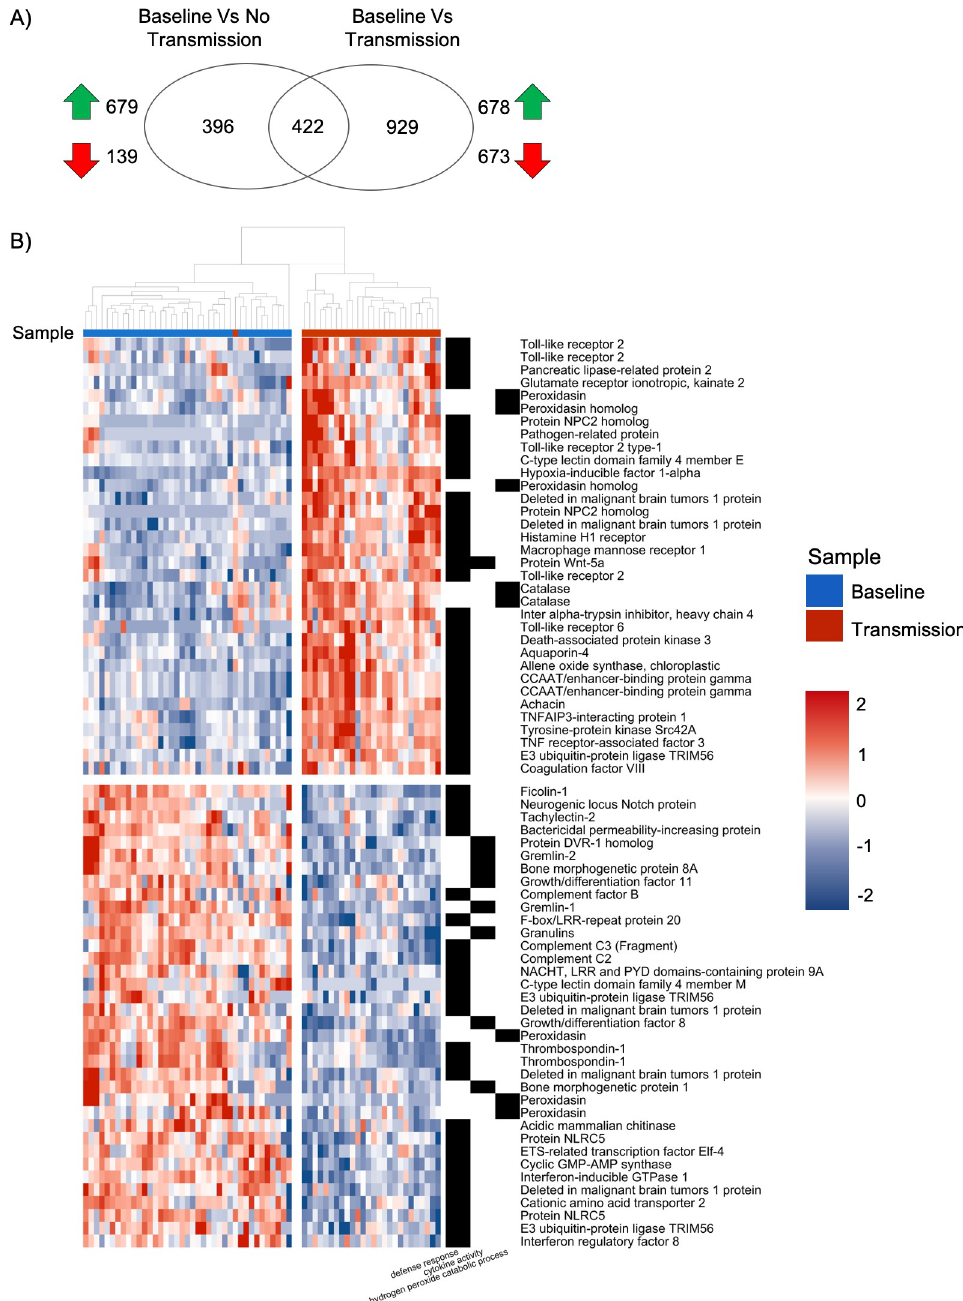
Fig 4. Unique and common genes between differential expression contrasts and significant innate immune genes in diseased corals. A) Venn diagram of the unique (left and right) and shared (intersect) differentially expressed genes from the two contrast arguments run in DeSeq2. The green arrows show significantly upregulated and the red arrows show significantly downregulated genes for each contrast. B) Heatmaps showing genes linked to significantly enriched innate immune gene ontology (GO) terms identified from the Baseline vs. Transmission DeSeq2 contrast. Samples included are Baseline (blue) and Transmission (red). Left heatmap fill shows higher (red) to low (blue) gene counts using a variance stabilizing transformation. Right heat map identifies genes present (black) or absent (white) from significantly enriched GO terms linked to innate immune response. Column dendrogram shows hierarchical clustering of samples. Rows (genes) also arranged using hierarchical clustering with dendrogram